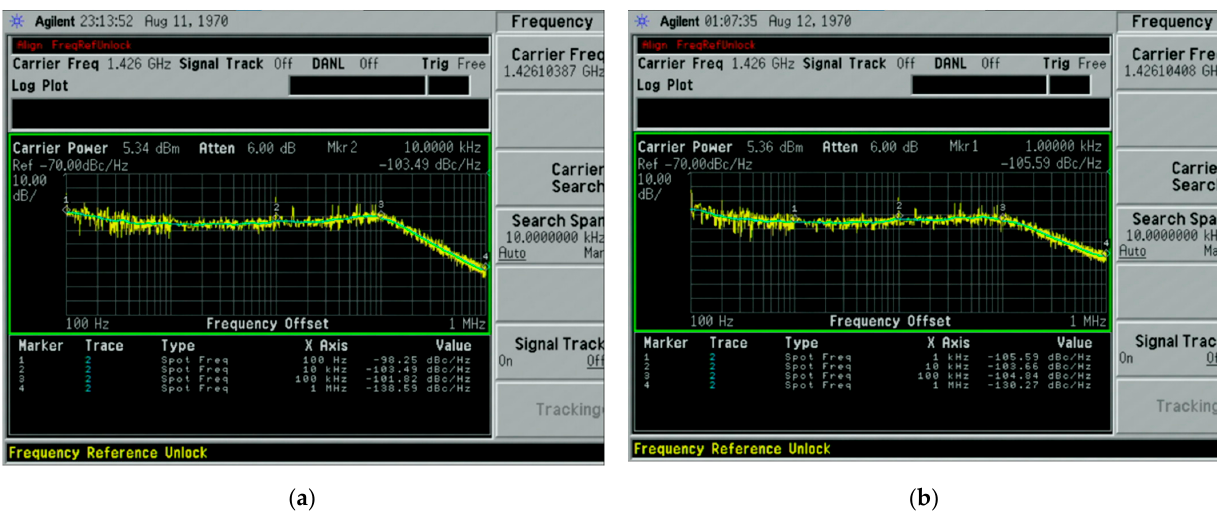
Figure 9. The output signal’s frequency spectrum.